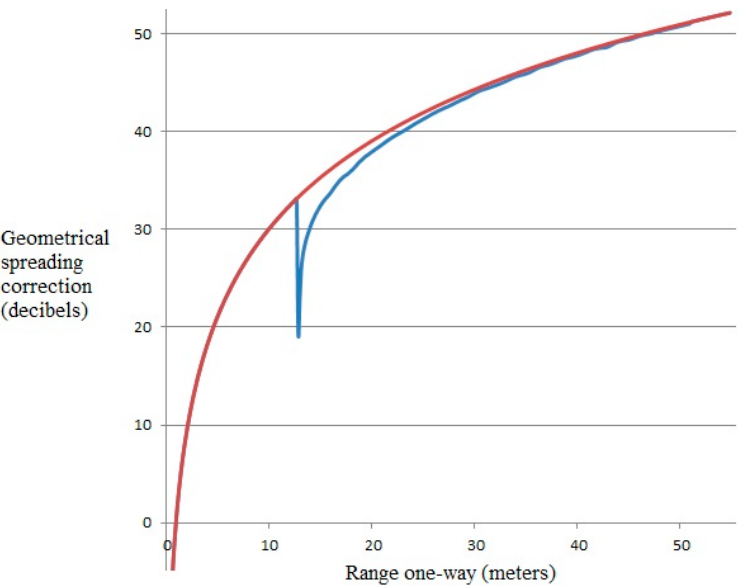
Figure 9. Graphs of geometrical spreading correction (decibels) for a single sonar trace (Figure 6) imaging the seabed as a function of range R (meters). A correction appropriate to apply as a far-range approximation 30 log R is shown in red, and a more accurate correction incorporating the second term on the right hand side of Equation (56) is shown in blue.